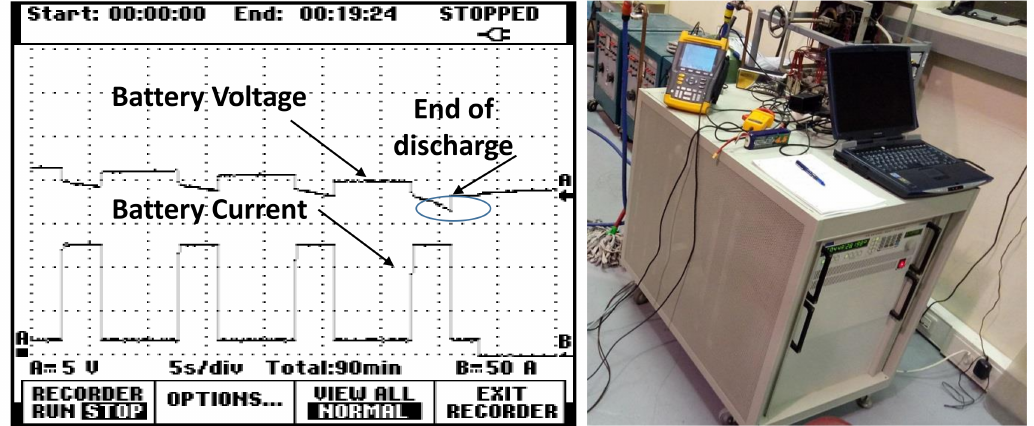
Figure 4. Typical waveforms during tests (pattern 1) and water-cooled programmable load used during tests.